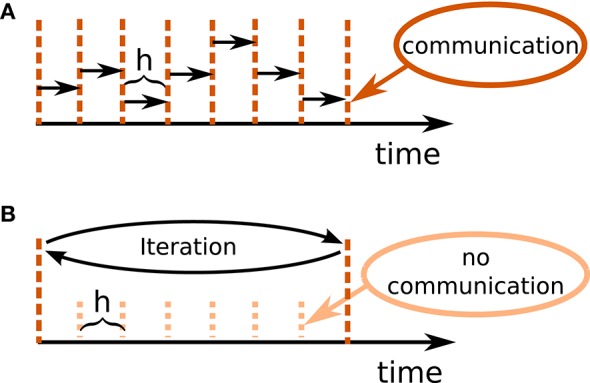
Different communication strategies for distributed simulations. Distance between neighboring dotted orange lines indicates computation time step of size h. Distance between neighboring dashed red lines symbolizes one communication interval where rates (and other events like spike events) are communicated at the end of the interval. (A) Standard solution for rate-based models: rates are communicated in every time step. (B) Iterative approach using waveform relaxation: rates are communicated only after Th steps and the entire interval is solved repeatedly.